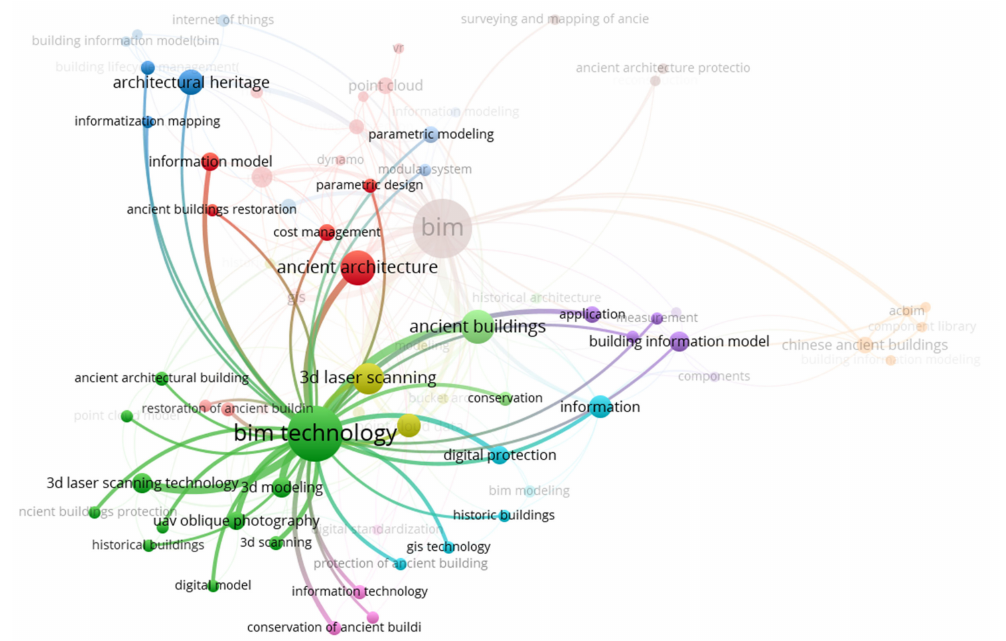
Figure 11. Keyword network visualization of “BIM technology”, created by